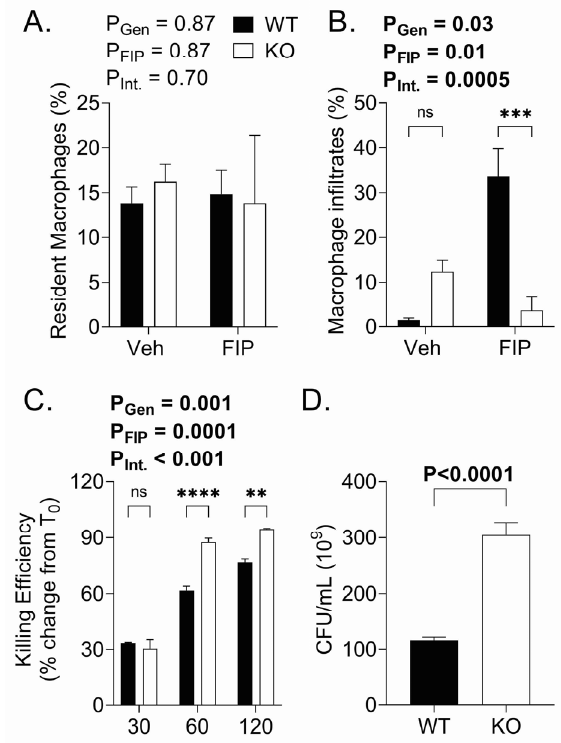
Figure 6. ( A ) Resident and ( B ) infiltrated macrophages assessed in peritoneal lavage in wild-type (WT) and OSMR type II receptor knockout (KO) mice subjected to fecal slurry-induced peritonitis (FIP) or injected with vehicle (Veh). The resident macrophages depicted in panel ( A ) were identified as CD11b+ F4/80+ Ly6c[low]+, and the macrophage infiltrates depicted in panel ( B ) were identified as CD11b+ F4/80+ Ly6c[high]+. ( C ) In vitro bacterial killing assay for wild-type (WT) and OSMR type II receptor knockout (KO) mice. ( D ) KO mice had reduced peritoneal bacterial clearance compared to WT mice. ( D ) In panels ( A , B ), the p values reflect the outcomes of 2-way analysis of variance; Sidak post-hoc tests outcomes are shown as ** p < 0.01, *** p < 0.001, **** p < 0.001, ns not significant. In panel ( D ) the, p values reflect the outcome of Student’s t test. Each bar represents n = 3–14 mice.